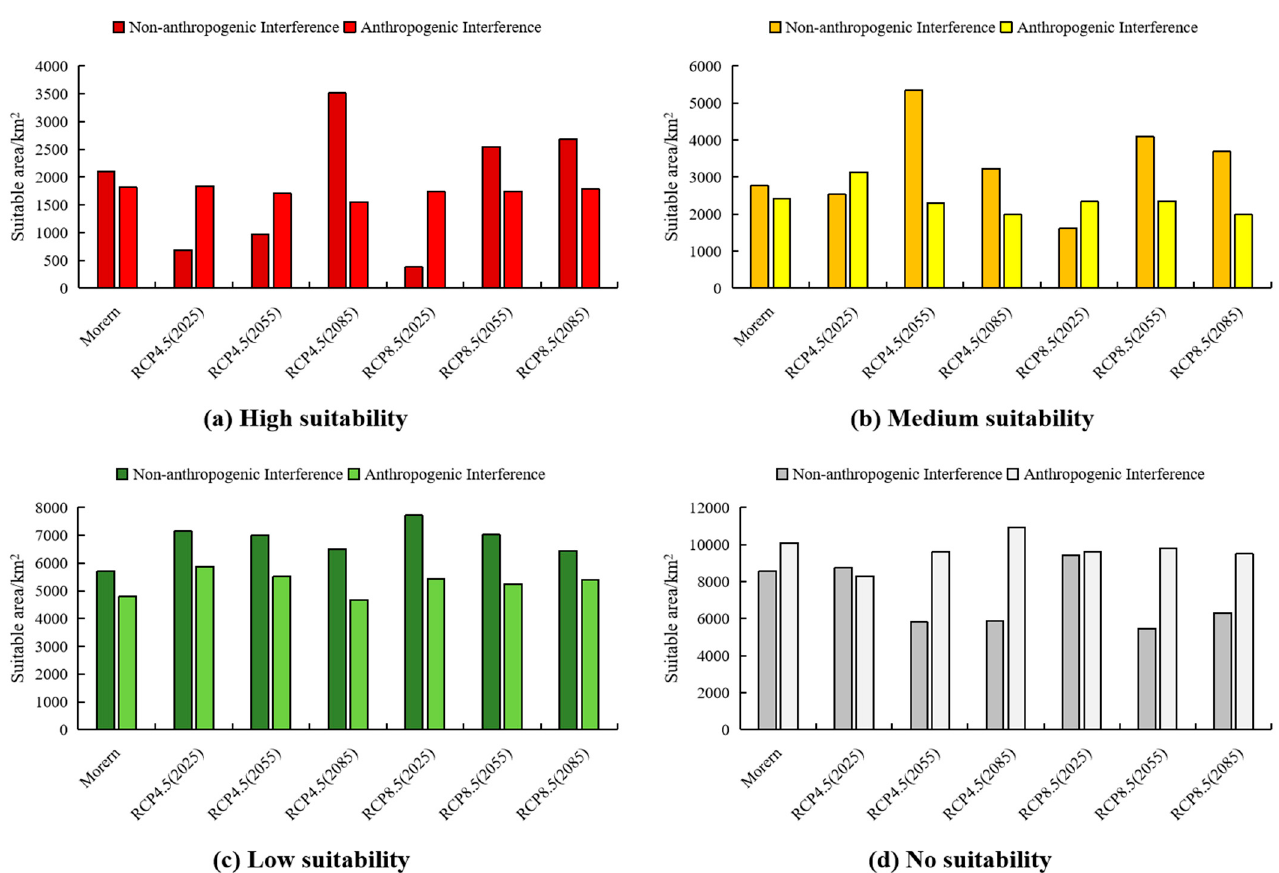
Figure 8. Changes in suitable areas for Asian elephants in Sipsongpanna under current and future climate scenarios (( a ) high-suitability areas; ( b ) medium-suitability areas; ( c ) low-suitability areas; ( d ) non-suitability areas).